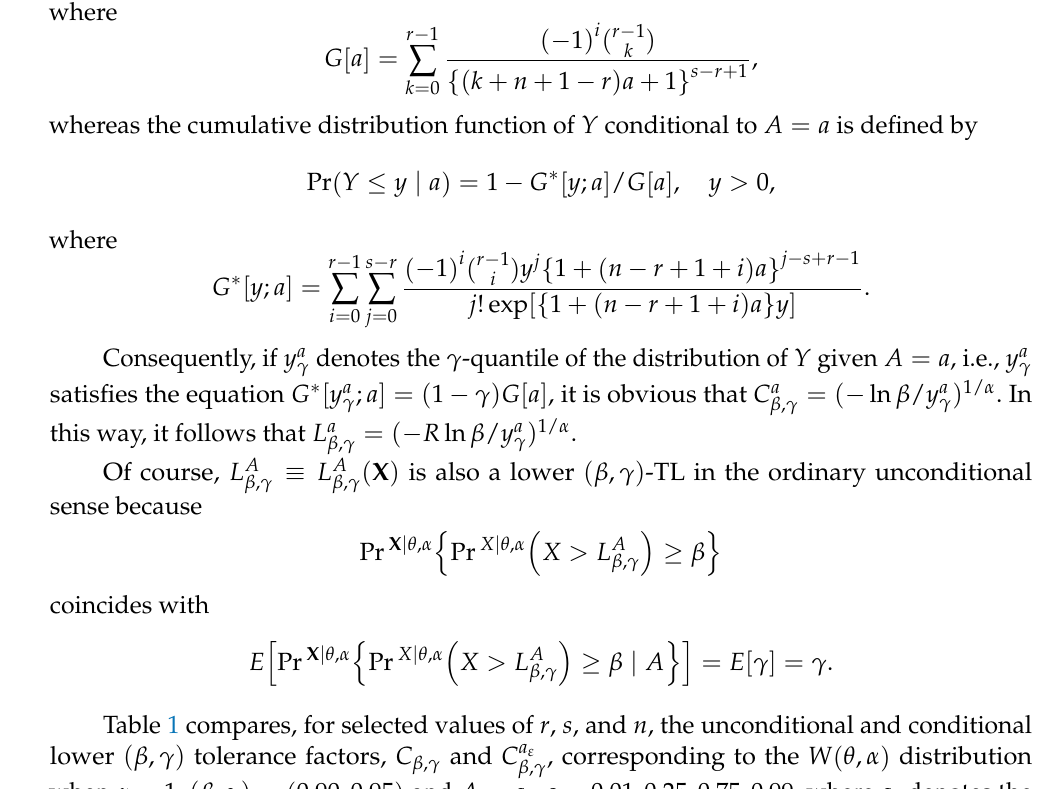
, for the W ( α , θ ) β , γ